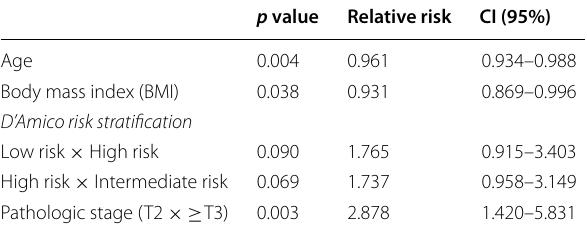
Table 5 Univariable analysis: independent predictors of the pentafecta p value Relative